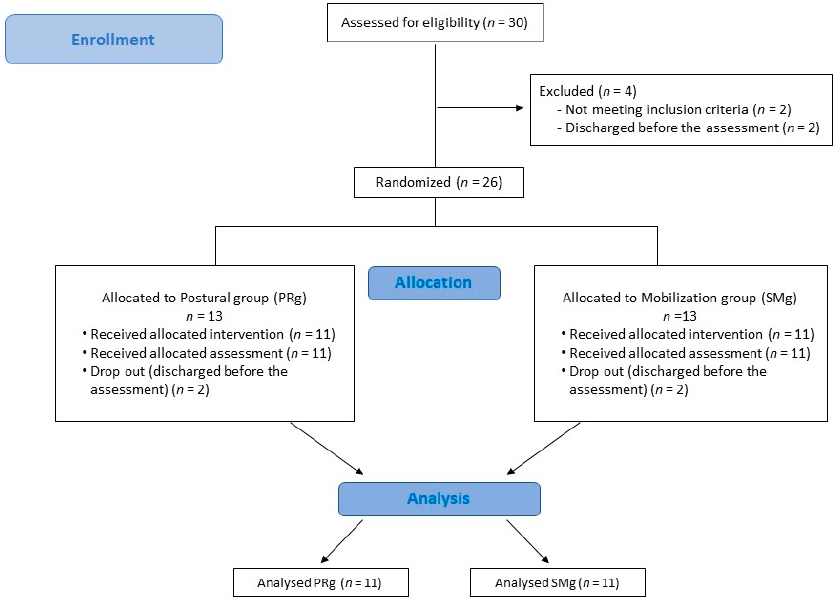
Figure 1. Flow diagram of the study design. Table 1. Demographic and clinical characteristics at the baseline of the